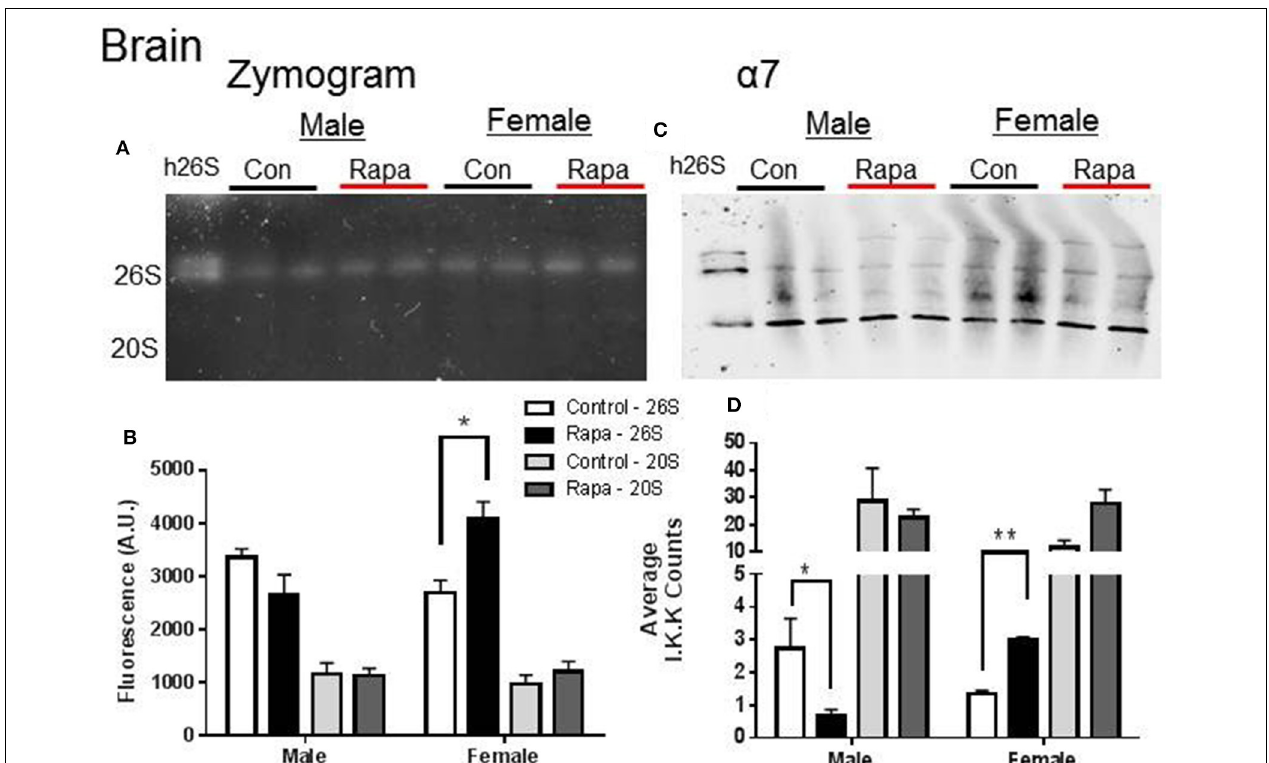
FIGURE 2 | Female Brain Lysates showed a rapamycin-dependent increase in 26S proteasome. (A) Representative zymogram of Chymotrypsin-like (ChTL) proteasome activity after native gel electrophoresis of 50 μ g of brain lysate from control and rapamycin-treated old male and female animals. (B) Quantitation of zymogram showed that there was a treatement-induced increase in 26S-specific ChTL proteasome activity in